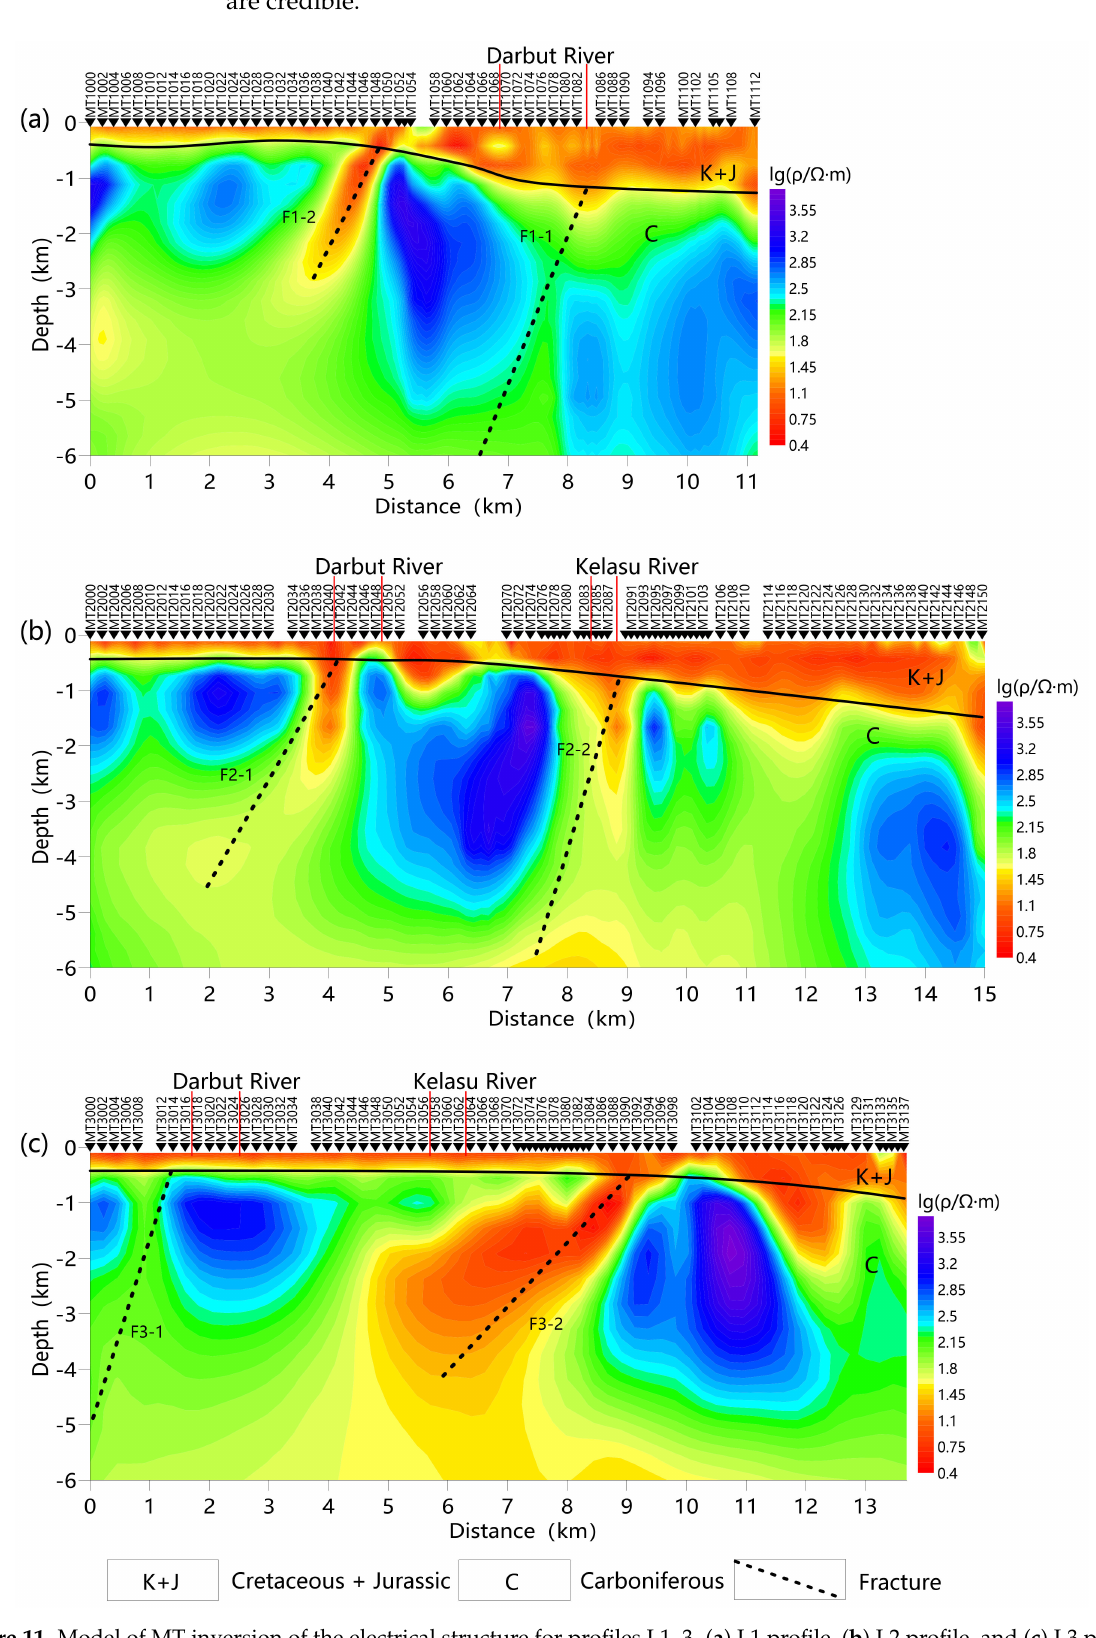
Figure 11. Model of MT inversion of the electrical structure for profiles L1–3. ( a ) L1 profile, ( b ) L2 profile, and ( c ) L3